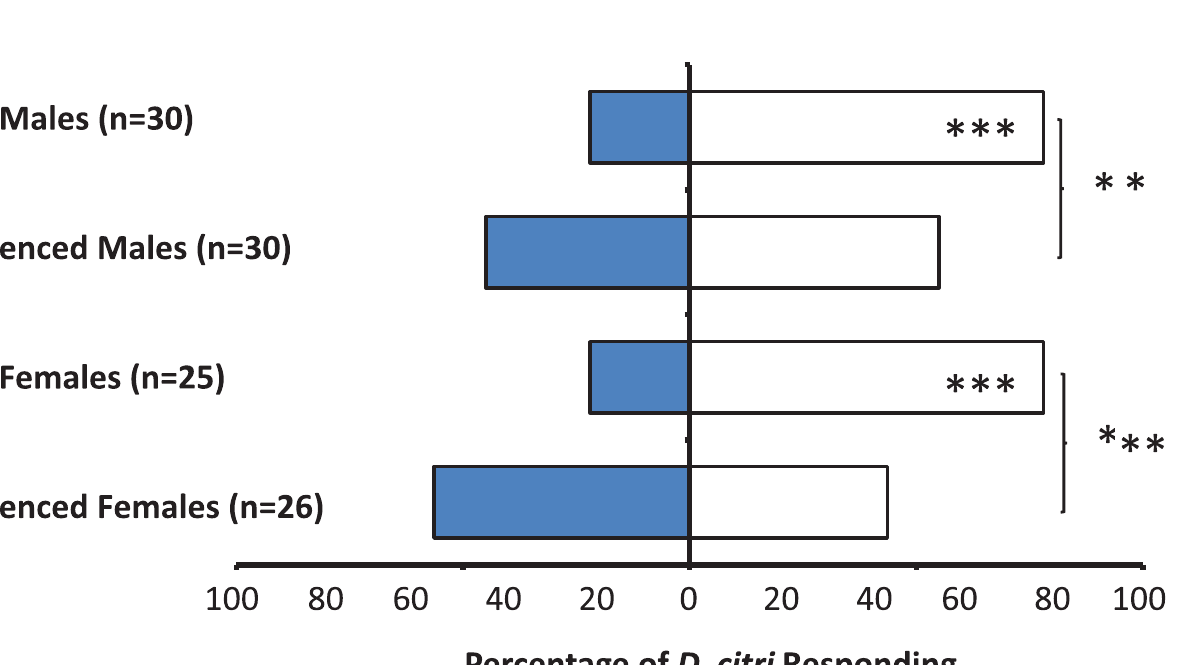
Fig 4. Learned response to a novel olfactory stimulus (a) and a visual stimulus (b). (a) Light gray bars indicate responses to a novel olfactory stimulus (vanillin odor). (b) Blue bars indicate the responses to a novel visual stimulus (blue light). (a, b) White bars indicate responses to the blank control. Asterisks ( * ) within bars indicate statistically significant differences within groups selecting arm A or arm B, while asterisks ( * ) outside bars indicate differences between na ï ve and experienced insects ( χ 2 test, * : < 0.05, ** : < 0.01, *** : < 0.001).